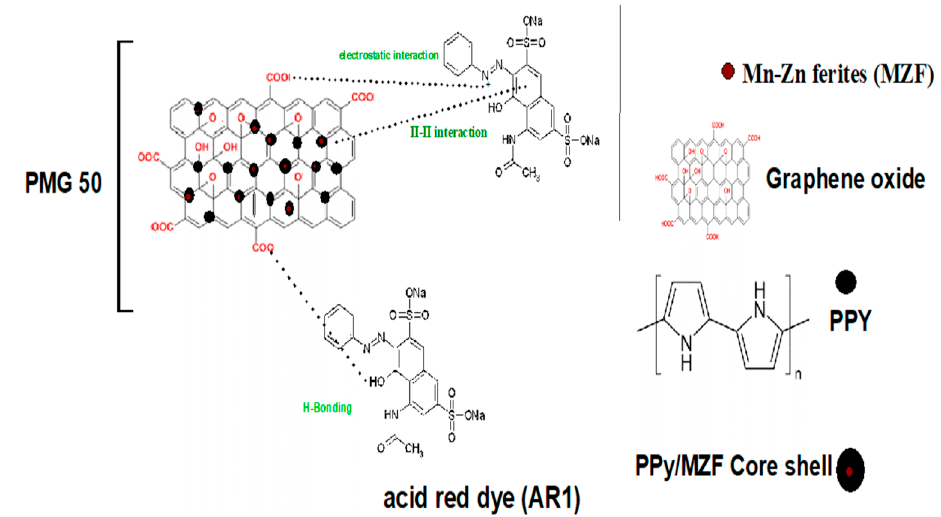
Figure 11. Probable adsorption mechanisms of acid red 1 (AR1) dye on PMG50 ternary composites.